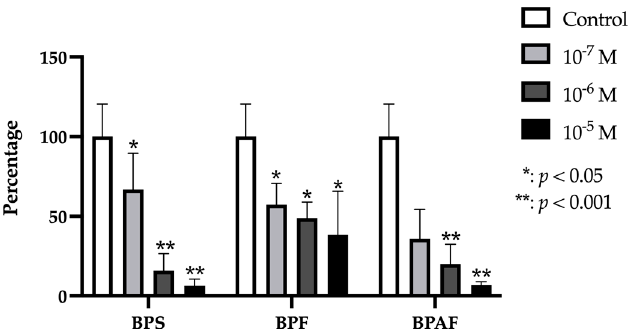
Figure 6. Expression of Col-1 in primary human osteoblasts treated for 24 h with bisphenol S, F, and AF (10 − 7 , 10 − 6 , or 10 − 5 M). The assay was performed in triplicate with each of the three primary human osteoblast cell lines. Data are expressed as percentage expression with respect to control ± standard deviation. Significant differences * p < 0.05; ** p < 0.001.